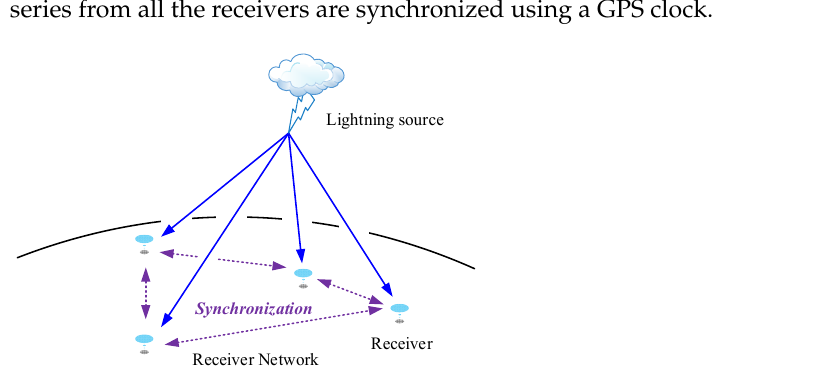
Figure 1. Illustration of the receiver network.